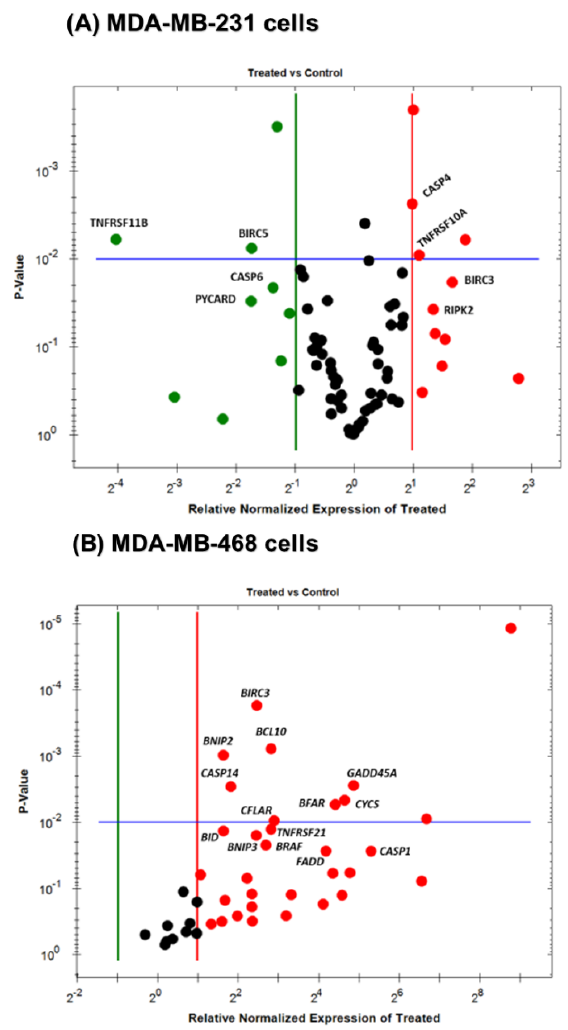
Figure 5. Classification of apoptosis-related gene expression induced by oleuropein (OL) in ( A ) MDA-MB-231 and ( B ) MDA-MB-468 TNBC cells. A volcano plot was performed to categorize and display upregulated (red), repressed (green), or unchanged (black) mRNA gene expression after a 48 h treatment period with 500 µ M in MDA-MB-231 cells and 250 µ M in MDA-MB-468 cells. The upregulated apoptosis-related genes were highly recognizable in MDA-MB-468 cells more than in MDA-MB-231 cells; meanwhile, green spots were only evident in MDA-MB-231